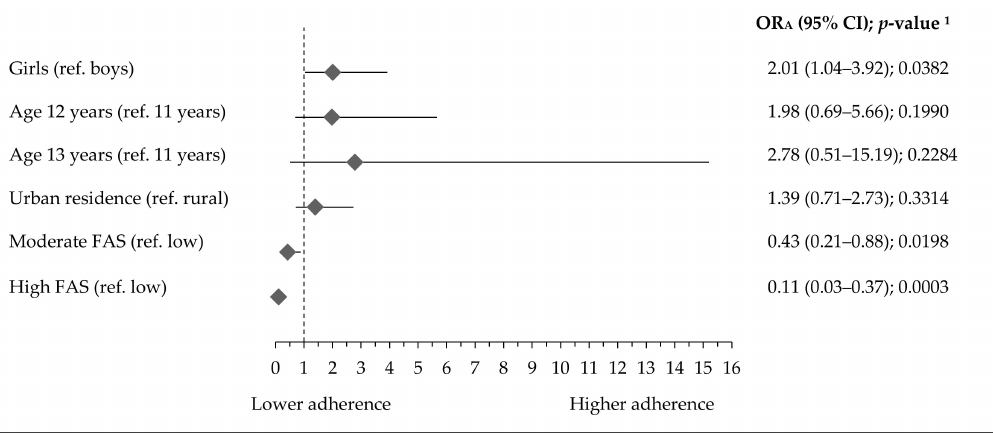
Figure 6. Factors associated with lowST-lowPA pattern in Polish teenagers (ref. lowST-highPA